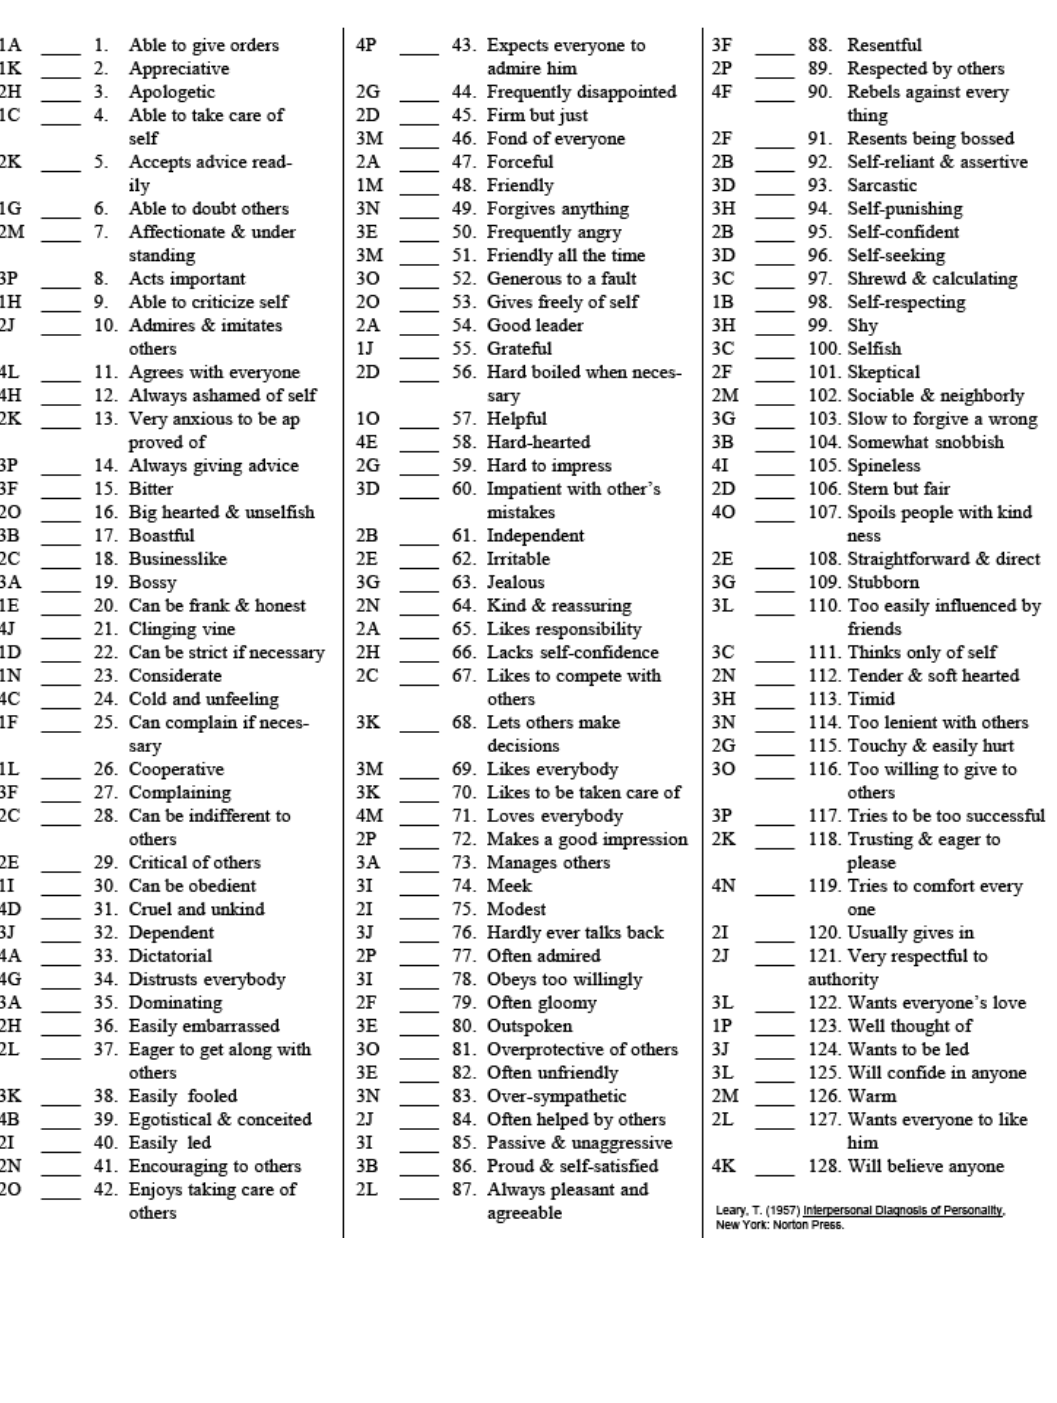
Instructions: Place a check mark  by the phrases which describe or apply to you, whether you engage in the behaviour frequently or only